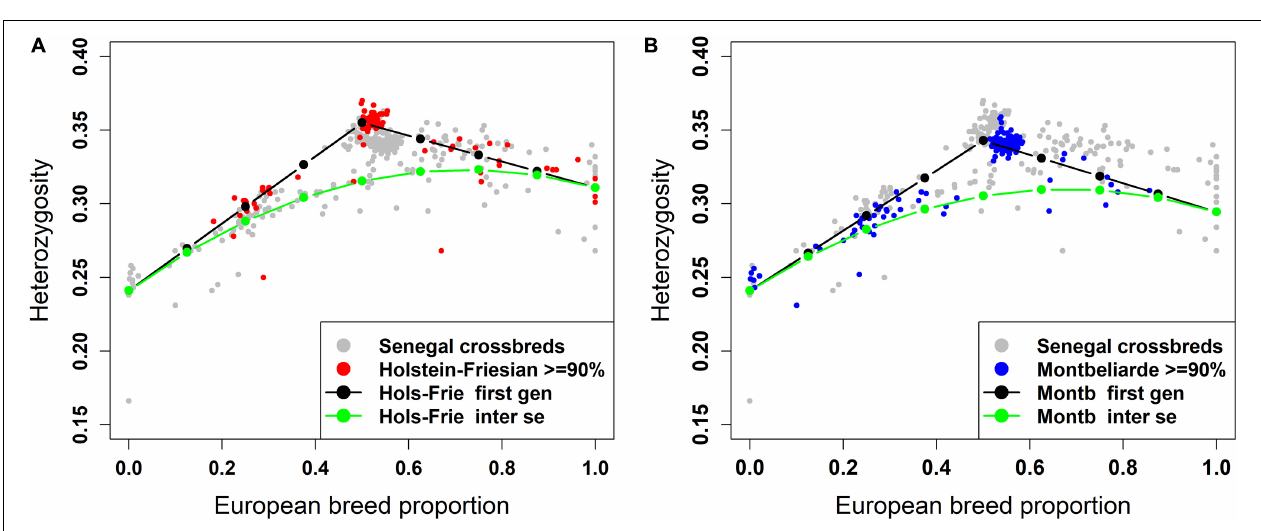
FIGURE 7 | Individual heterozygosity in West African crossbreds plotted against European breed proportion estimated from a three-way admixture using ADMIXTURE. The black and green lines are upper and lower boundaries of expected heterozygosity for (A) Holstein-Friesian and (B) Montbéliarde crosses.